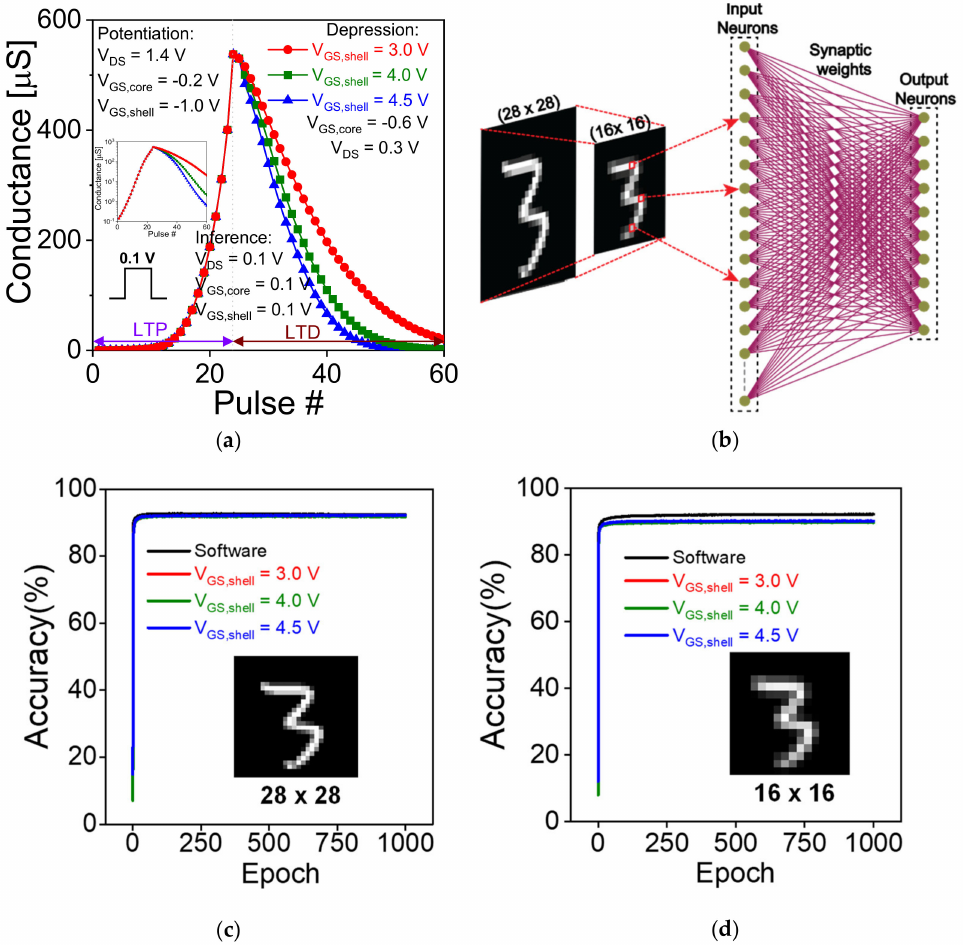
Figure 10. ( a )Variation in conductance value for Long term potentiation (LTP) and Long-term de- pression (LTD) characteristics of the CSDG device ( b ) schematic of the single layer neural network with the CSDG transistor as the synapse for Modified National Institute of Standards and Tech- nology (MNIST) digit recognition. Digit recognition accuracy (%) as a function of the number of training epochs at three distinct depression voltages of the synaptic device for ( c ) 28 × 28 and ( d ) 16 × 16 MNIST dataset. Inset of ( c , d ) shows the MNIST image of digit “3” in 28 × 28 and 16 × 16 resolutions,